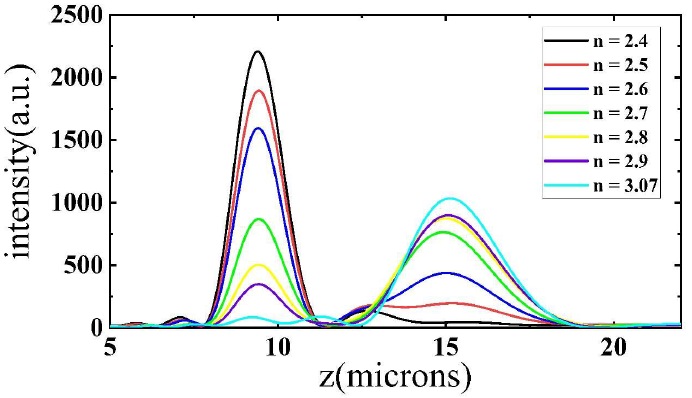
Figure 7. Simulated intensity results along z-axis when the refractive index of BTO changed. Table 1. The focusing performance of the bifocal metalens with different refractive